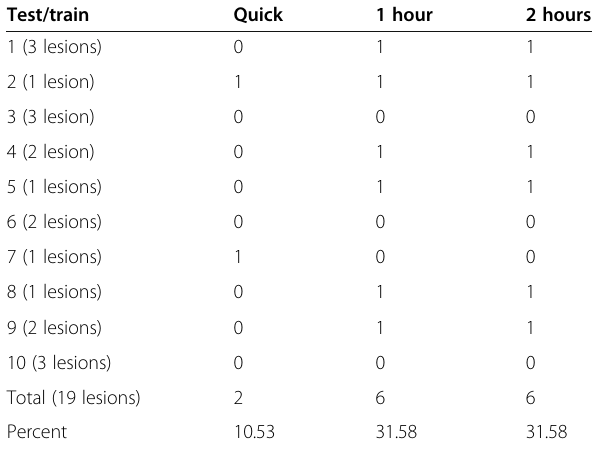
Table 2 The clinical performance of 5 training datasets Test/train 30 tags 60 tags 100 tags 130 tags 160 tags